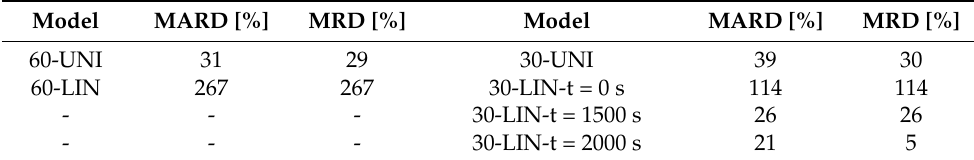
Table 4. MARD and MRD for the OLGA model for air–water–foam